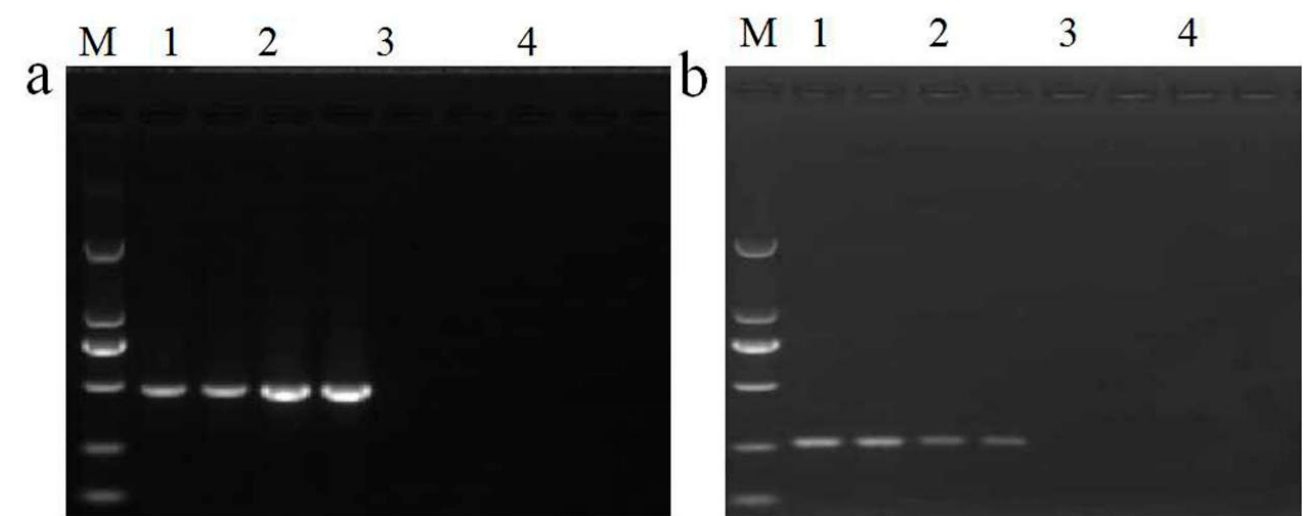
Figure 3. Assessment of applicability for qualitative PCR detection. ( a ) Screening of HPT gene in routine samples. Lane M: DL 2000 DNA Marker. Lane 1: routine testing rice material 2519, Lane 2: